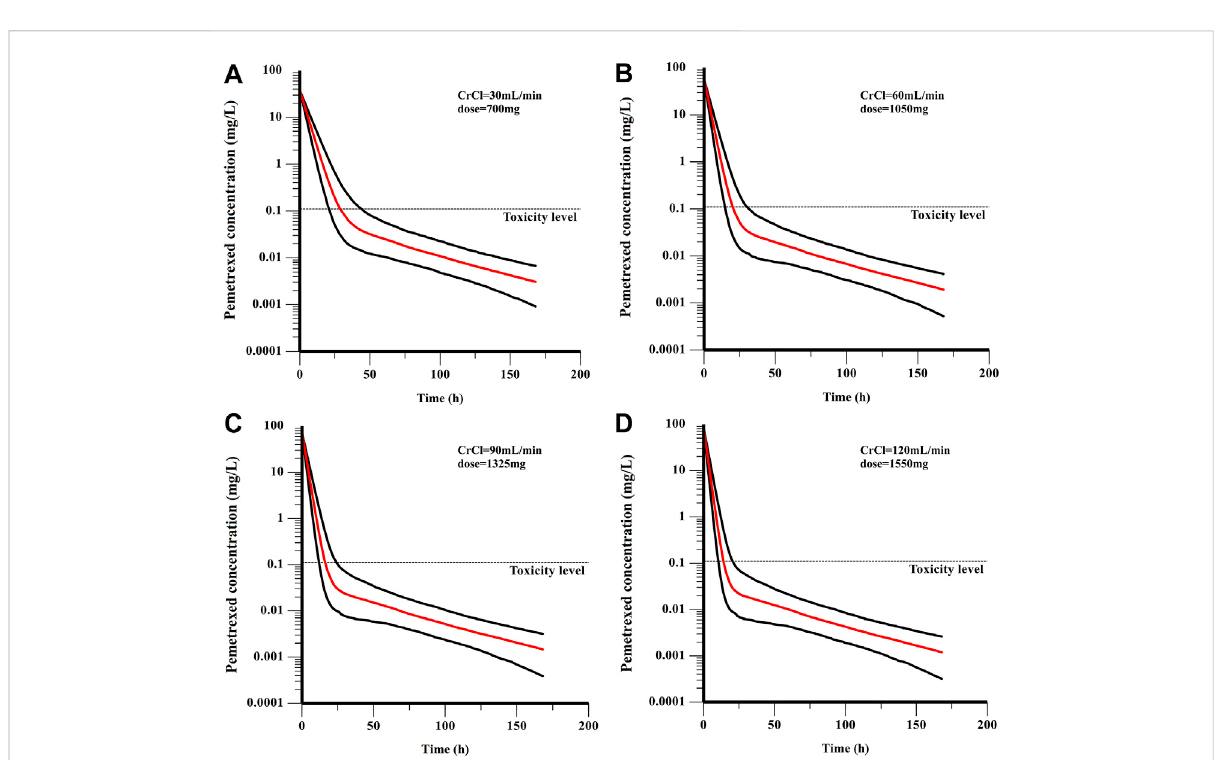
FIGURE 6 The PEM concentration-time curves of various dosing paradigms for patients with different renal function: (A) CrCl = 30 mL/min, dose = 700 mg; (B) CrCl=60 mL/min,dose=1050 mg; (C) CrCl=90 mL/min, dose=1325 mg; (D) CrCl=120 mL/min,dose=1550 mg.Theredlineisthe median of the simulated concentration, and the black lines represent the 10th and 90th percentiles of the simulated data.